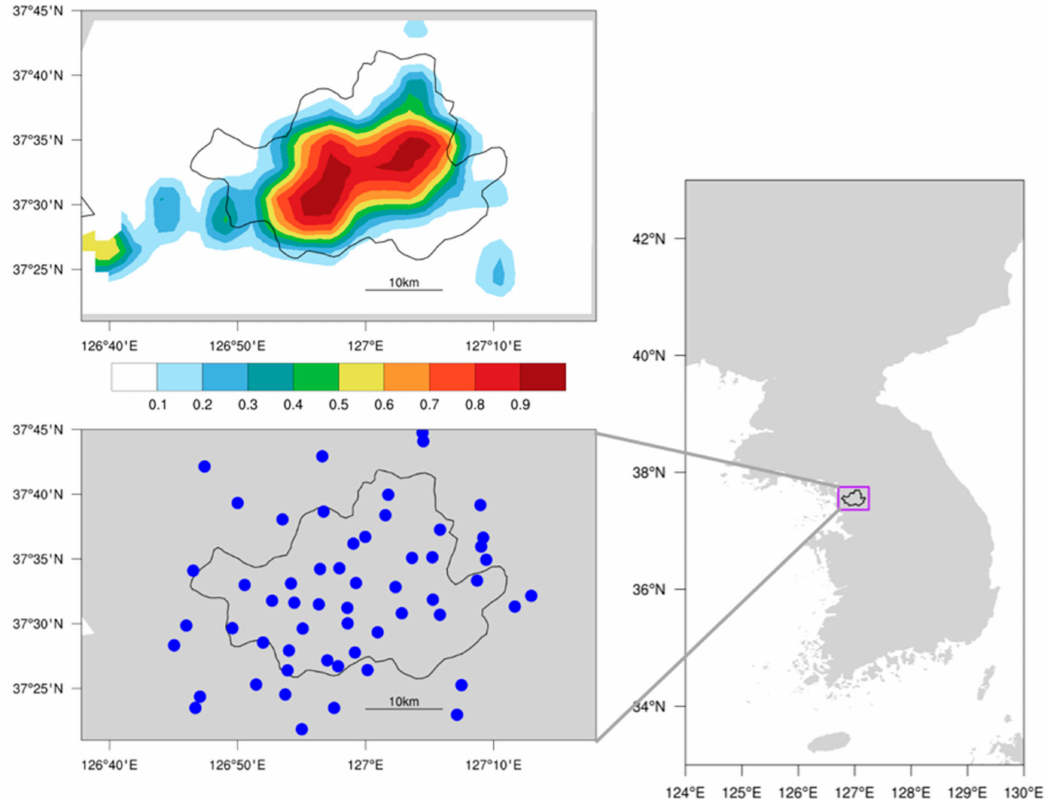
Figure 1. Locations of the Seoul Metropolitan Area ( right ) and 56 automatic weather stations (AWS) for validation ( lower left ), and urban fraction ( upper left ). Black line indicates the boundary of Seoul city and purple line indicates the Seoul Metropolitan Area in this